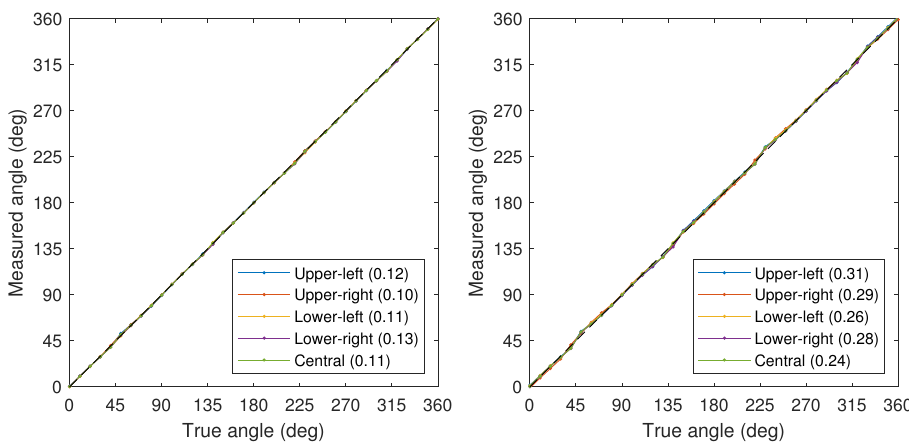
Figure 8. ( Left ): Variation of measured median angles for various ROIs (see Figure 9) as a cured UD sample is rotated on a turntable under dark field illumination. Measured angles are outputs from the polarisation method while true angles are recorded from the turntable control software. RMS angular errors for each ROI are shown in the legend. ( Right ): Identical test on a dry UD